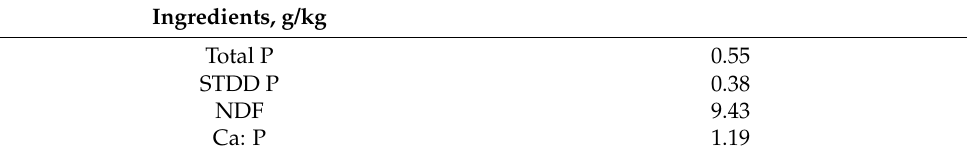
Table 1. Cont. Ingredients, g/kg Total P 0.55 STDD P 0.38 NDF 9.43 Ca: P